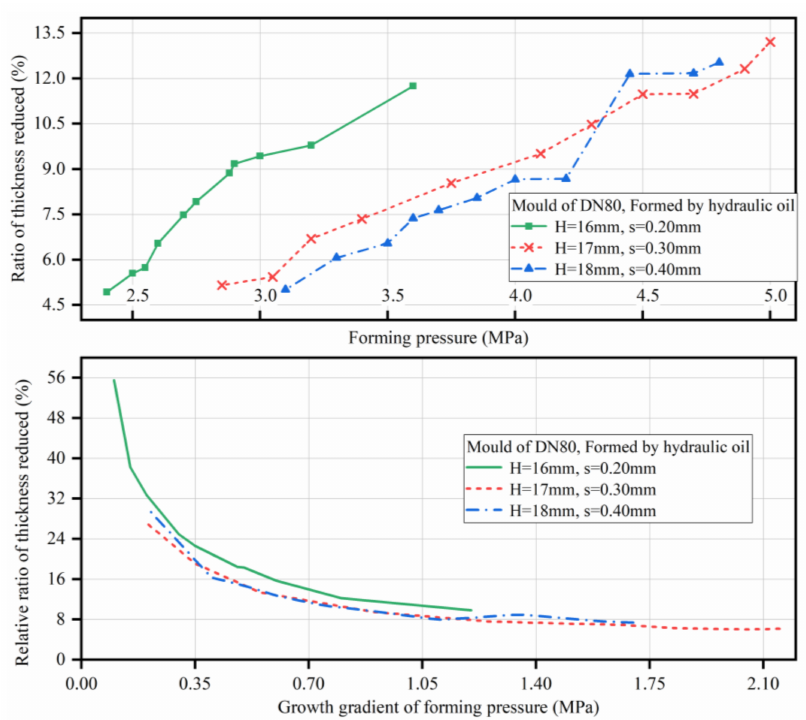
Figure 17. Absolute and relative ratios of thickness reduction for Dn 80 mm rupture discs formed by hydraulic